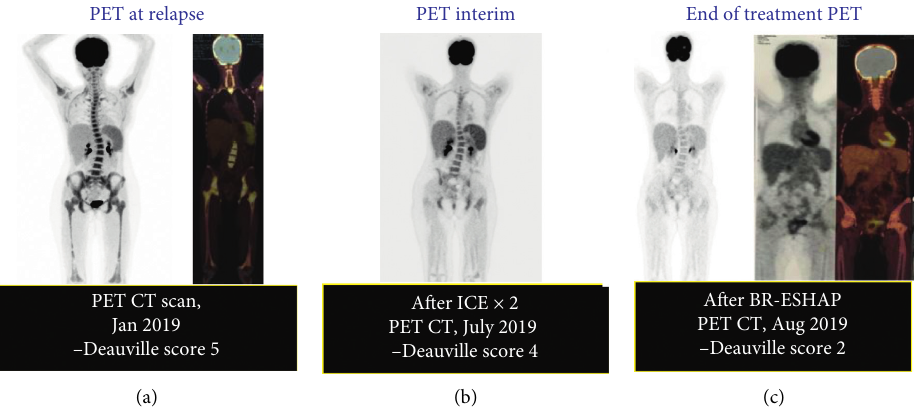
Figure 2: Clinical course of the patient at relapse. (a) First early relapse showing bone marrow progression (Ann-Arbor IVB-E); (b) partial remission after 2 cycles of the first ICE salvage treatment, with faint uptake over the bone marrow; and (c) complete remission after 2 cycles of second salvage using the brentuximab vedotin-ESHAP protocol.